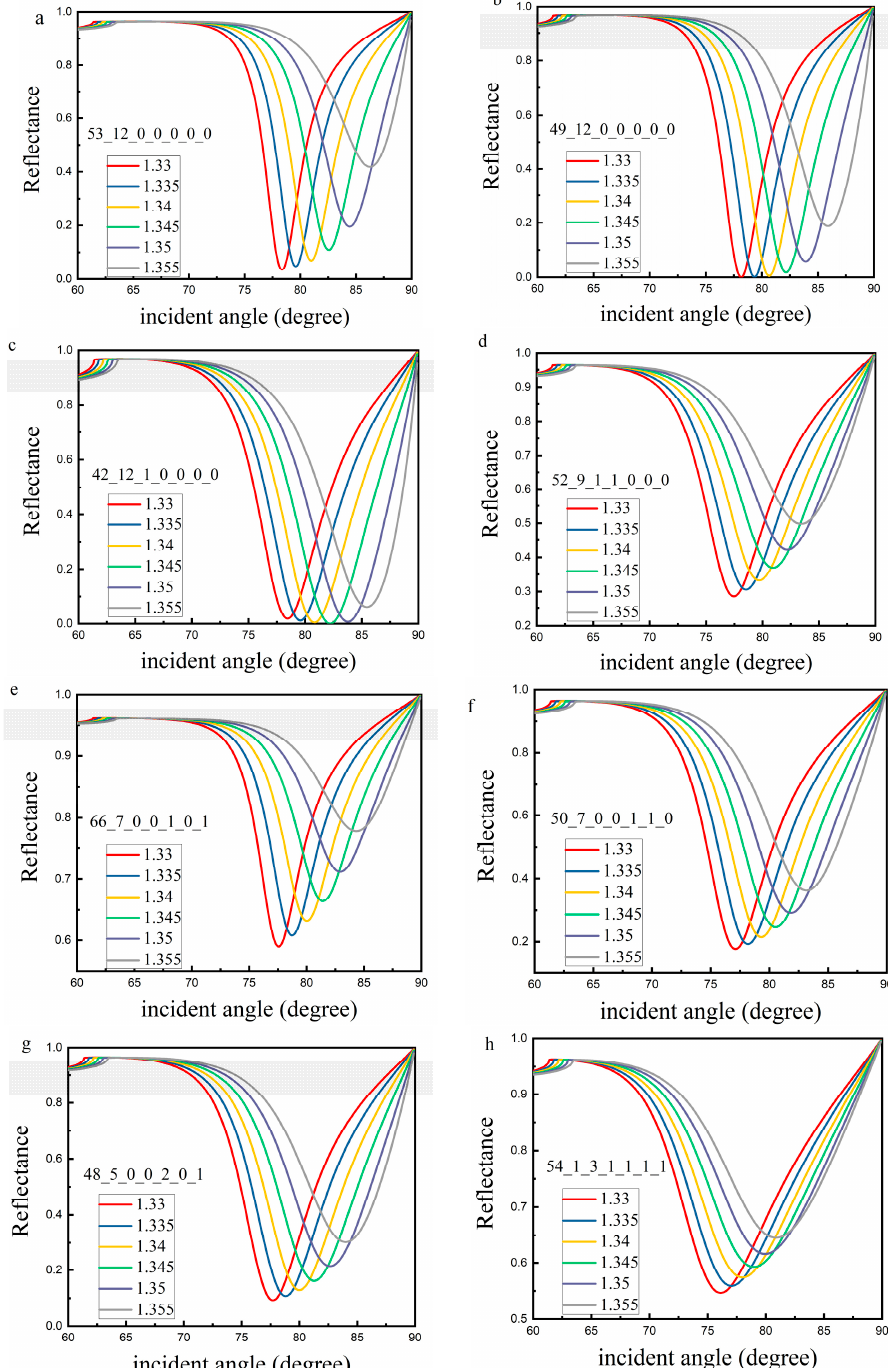
Figure 3. SPR curves changes when the refractive index of sensing medium changes from 1.33 to 1.355 under the set of parameter values in Table 5. ( a – h ) corresponds to the configuration 1–8 in Table 5,